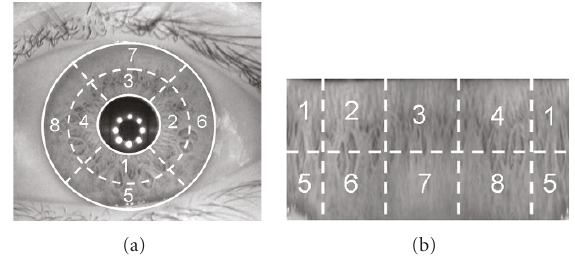
Figure 11: (a) The 8 areas in the source image, (b) corresponding to 8 rectangular blocks in the unwrapped image (128 ×